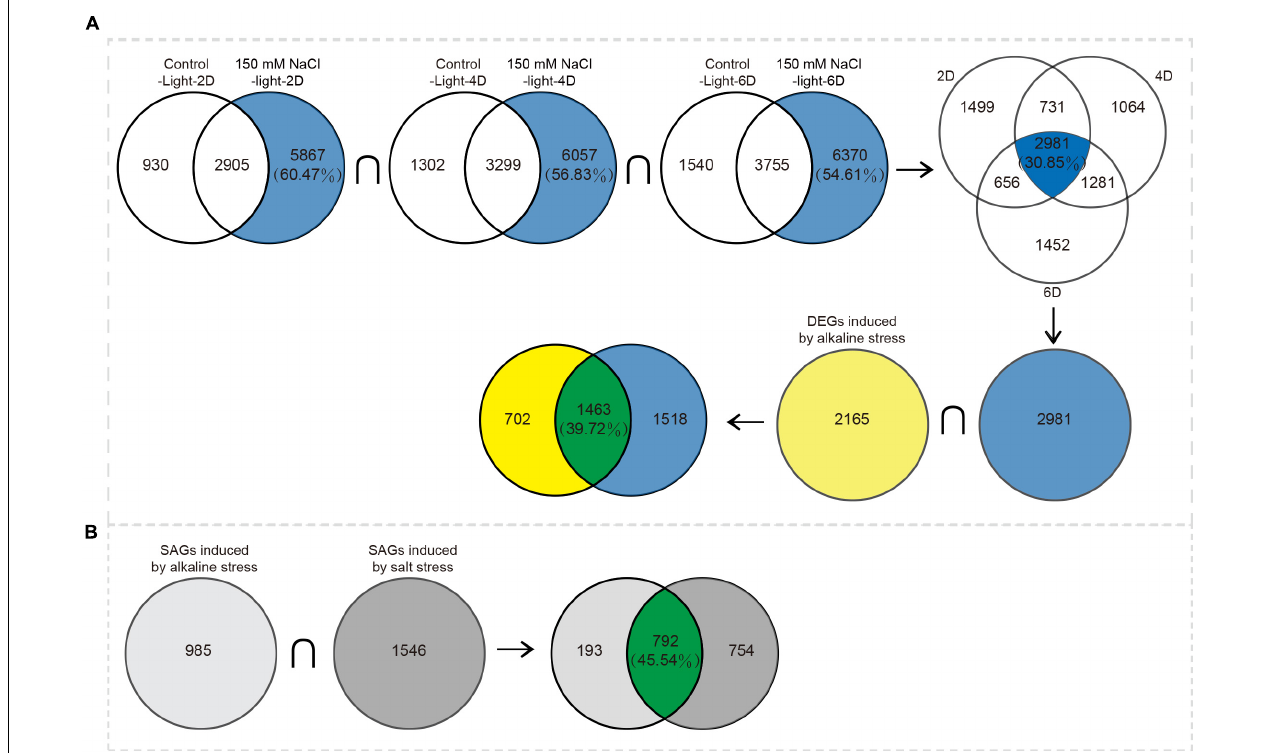
FIGURE 7 | Venn diagram analysis of DEGs induced by alkaline stress and by salt stress. (A) Differences between DEGs induced by alkaline stress and by salt stress. (B) Differences between SAGs induced by alkaline stress and by salt stress.